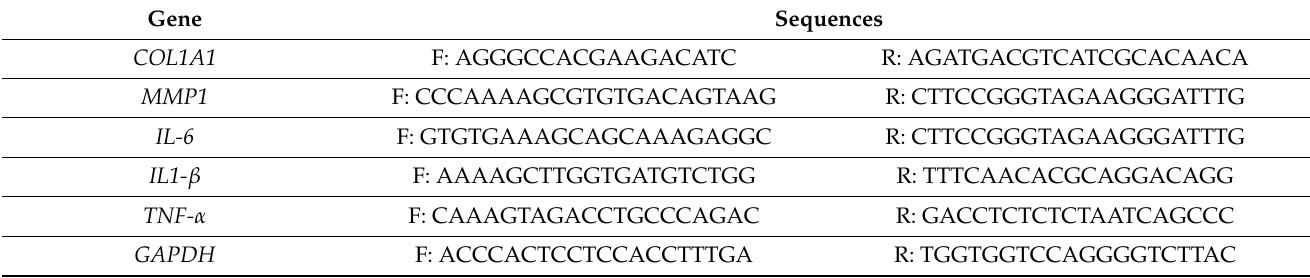
Table 3. The oligonucleotide primer sequences used in